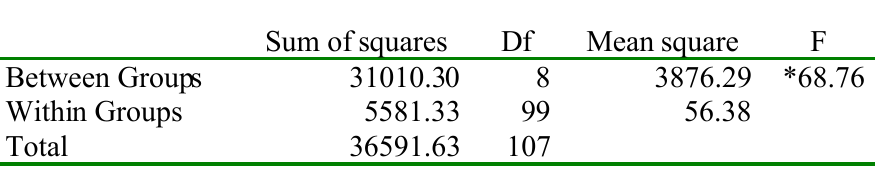
Analysis of Variance for Verb Category Use